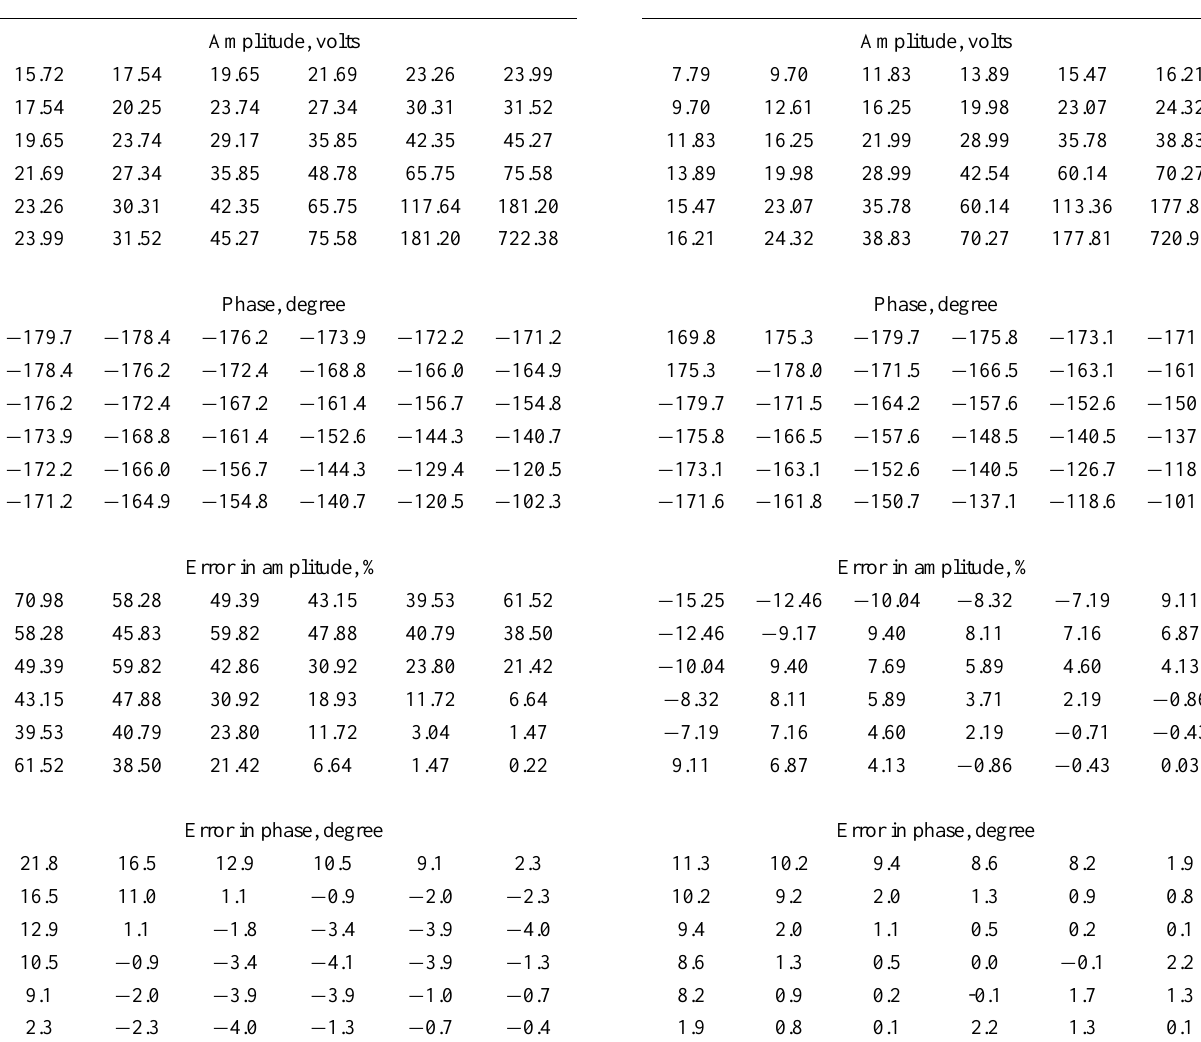
Table 3. Test case 3: high frequency, dense grid. Table 4. Test case 4: high frequency, dense and large